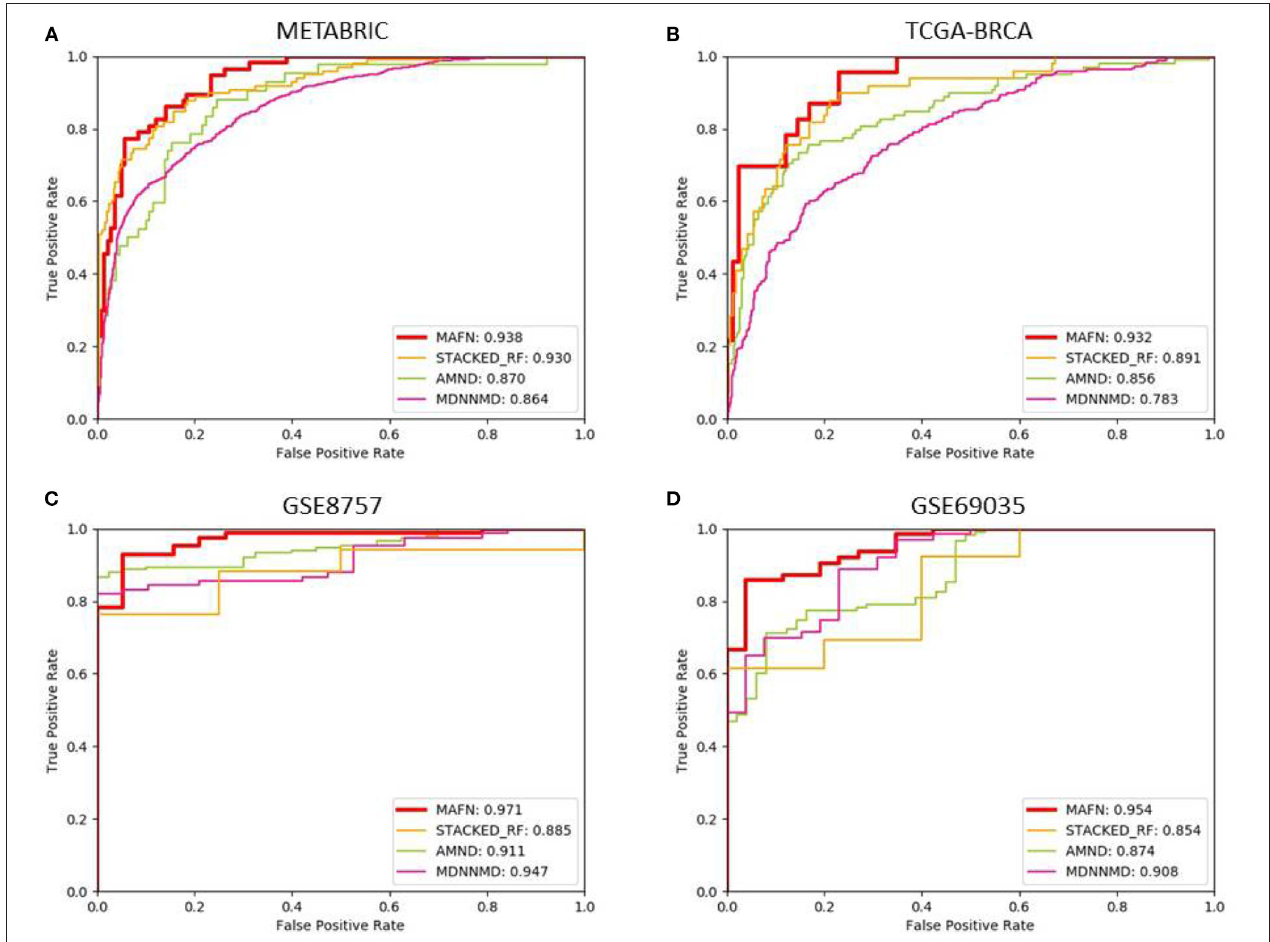
FIGURE 6 | Comparison of ROC curves of multimodal affinity fusion network (MAFN) and existing deep learning-based methods. (A) The result in METABRIC dataset; (B) the result in TCGA-BRCA dataset; (C) the result in GSE8757 dataset; (D) the result in GSE69035 dataset.